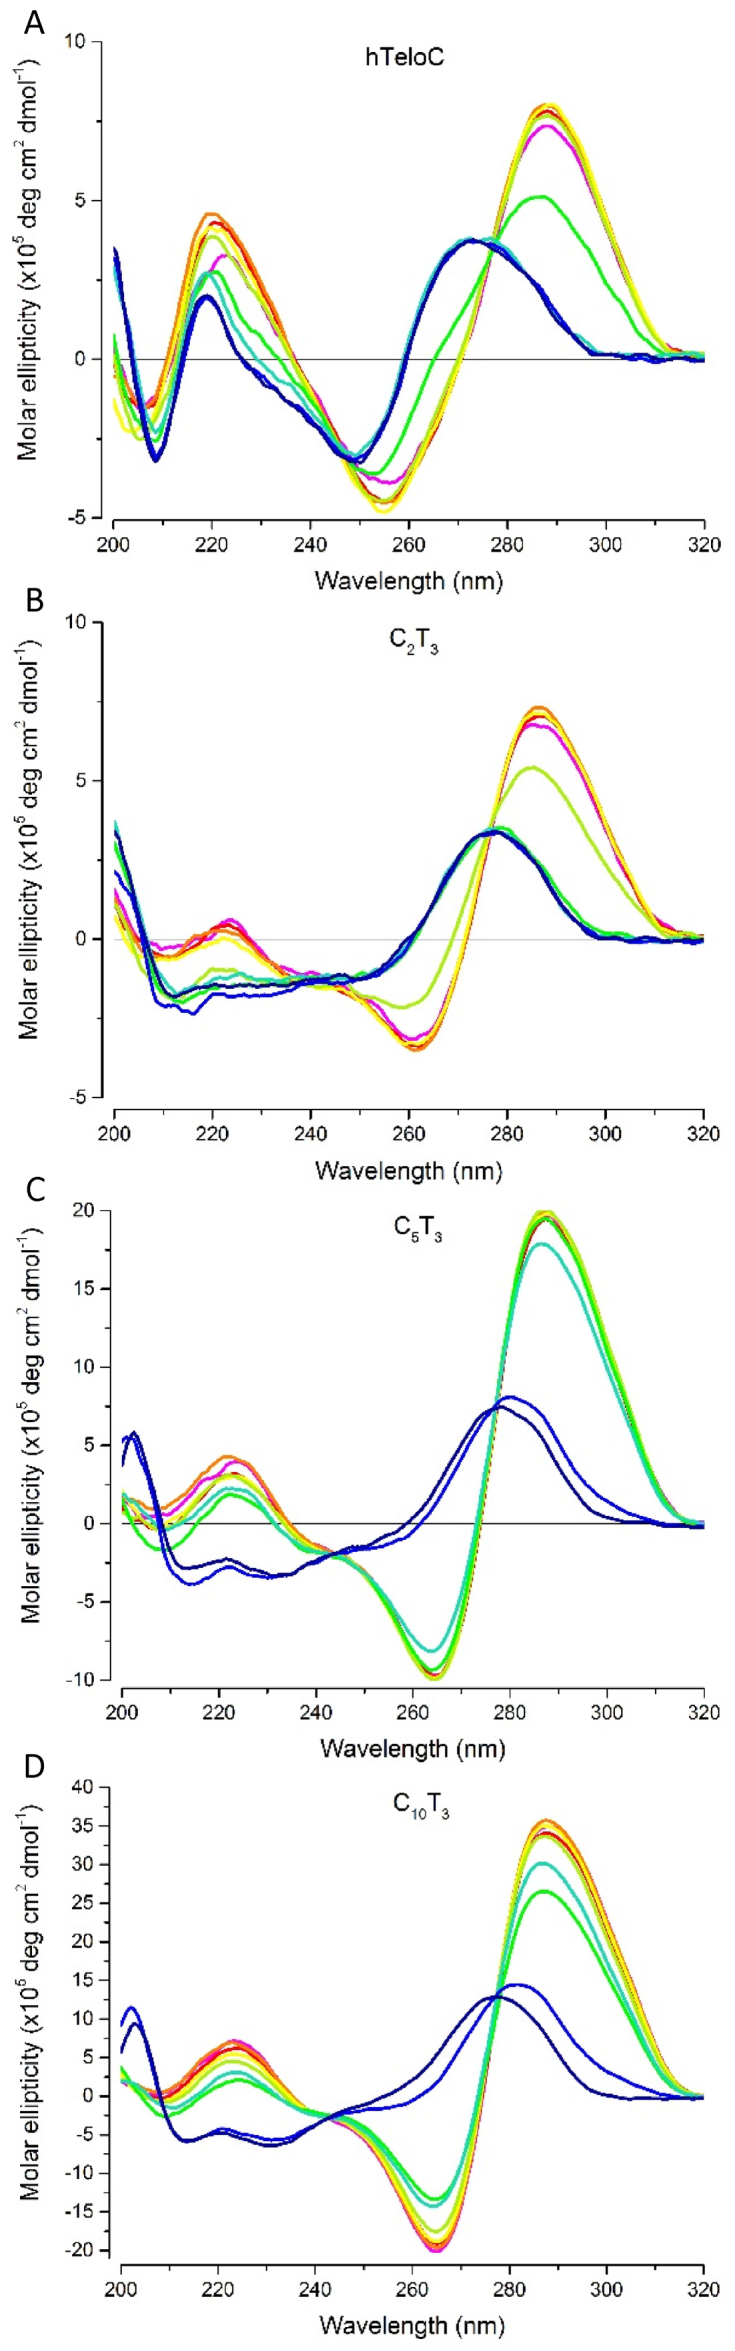
Circular dichroism of (A) human telomeric i-motif; (B) C2T3; (C) C5T3 and (D) C10T3.  pH 4.0;  pH 4.5;  pH 5.0;  pH 5.5;  pH 6.0;  pH 6.5;  pH 7.0;  pH 7.5;  pH 8.0. All ODN concentrations were 10 μM in 10 mM sodium cacodylate buffer with 100 mM sodium chloride buffer at the required pH.